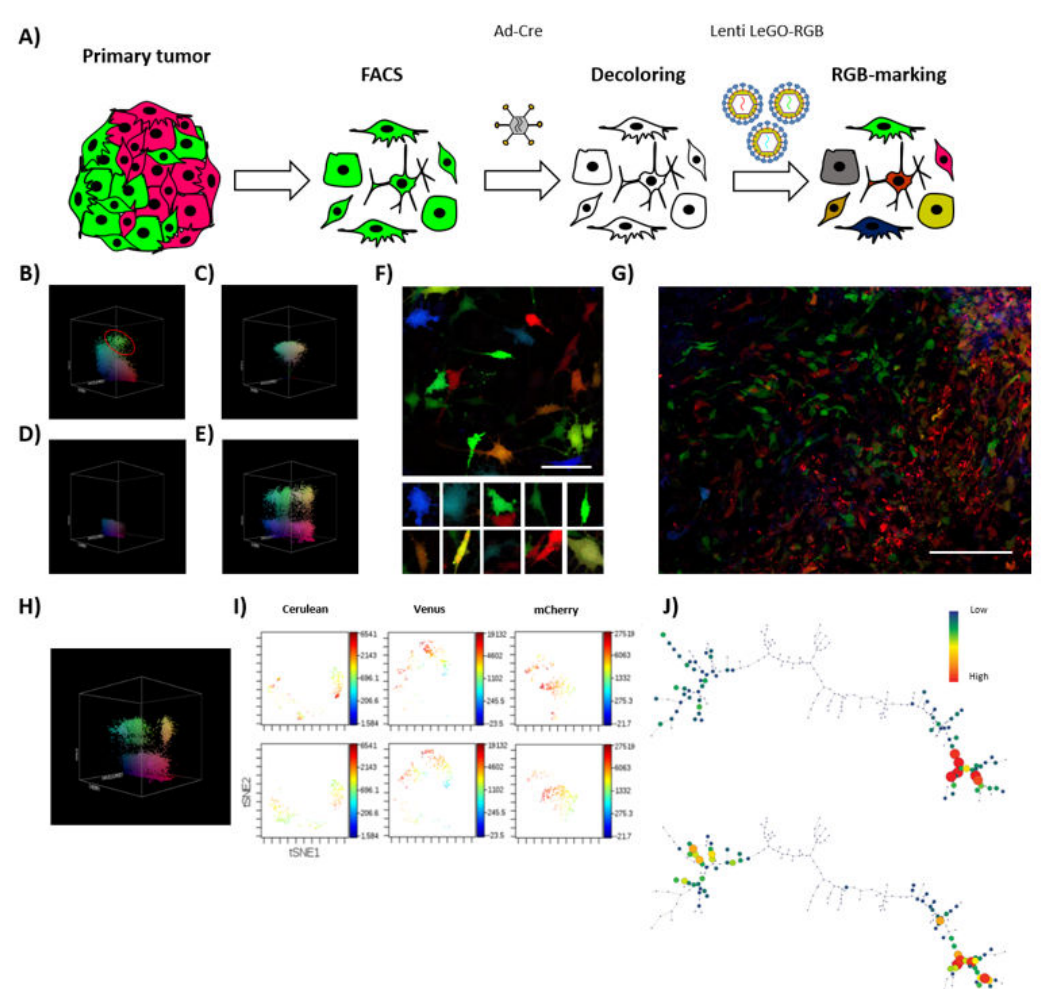
Figure 4. Tumor-derived clones grow neutrally at sub-clonal level. ( A ) The schematic shows the process of isolation, decoloring, and re-coloring, performed to study the sub-clonal dynamics of a clonal population isolated from primary tumors. ( B ) Representative 3D flow cytometry dot plot showing the clonal composition of K5 RGB-marked tumors at 35 days of primary transplantation; red circle indicates a FACS-grouped clone. The three dimensions of the 3D dot plot represent the three RGB fluorescent variants: Cerulean, Venus and mCherry. Dots are colored according to their fluorescent marker expression or their possible combinations. ( C ) Representative 3D flow cytometry dot plot showing a FACS-grouped tumor-derived clones after in vitro culture. ( D ) Representative 3D flow cytometry dot plot showing fluorescent marker expression loss after the Ad-Cre transduction of sorted tumor-derived clones. ( E ) Representative 3D flow cytometry dot plot showing fluorescent markers expression after RGB re-coloring of sorted tumor-derived clones. ( F ) Representative confocal microscopy image of re-traced tumor-derived clones; note the color and morphological heterogeneity in the picture series presented at the bottom of the figure. White bar: 50 µ m. ( G ) Representative confocal microscopy image of tumors generated at secondary transplantation by retraced tumor-derived clones; note that both sub-clonal cell mixing (left) and an almost-homogeneous clonal development (right) occur. White bar: 100 µ m. ( H ) Representative 3D flow cytometry dot plot showing fluorescent marker expression of tumor cells after secondary transplantation. ( I ) Representative viSNE analysis of retraced monoclonal population in vitro (day 0, top) and in vivo (day 20, bottom). ( J ) Representative SPADE analysis of K5 RGB cells in vitro (day 0, top) and in vivo (day 20, bottom). The complete viSNE and SPADE tree analyses are presented in Figure